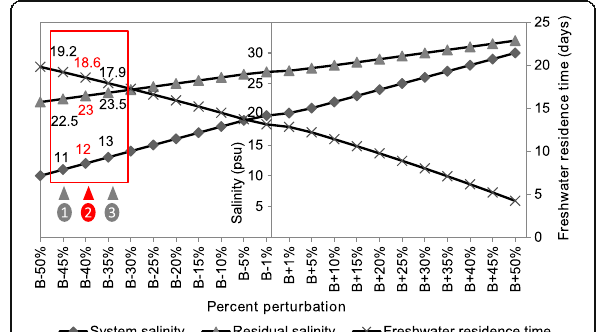
Fig. 8 Sensitivity parameters and models of perturbation i.e., the extent of desalination of Pulicat lagoon corresponding to changes in the system (Pulicat) and sea (Bay of Bengal) salinities as well as the freshwater residence times. The sensitivity models were constructed using the tool developed by Swaney and Hong